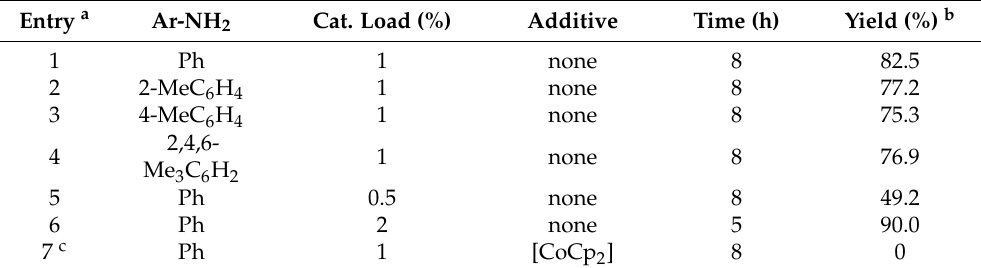
Table 13. The activity of complex in the hydroamination of phenylacetylene with arylamine.